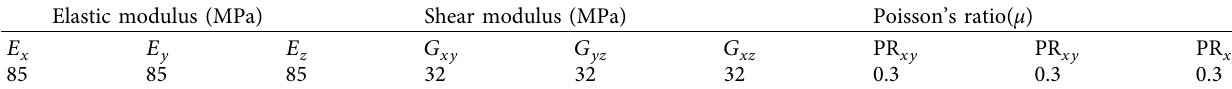
Table 2: A550 core material parameters.